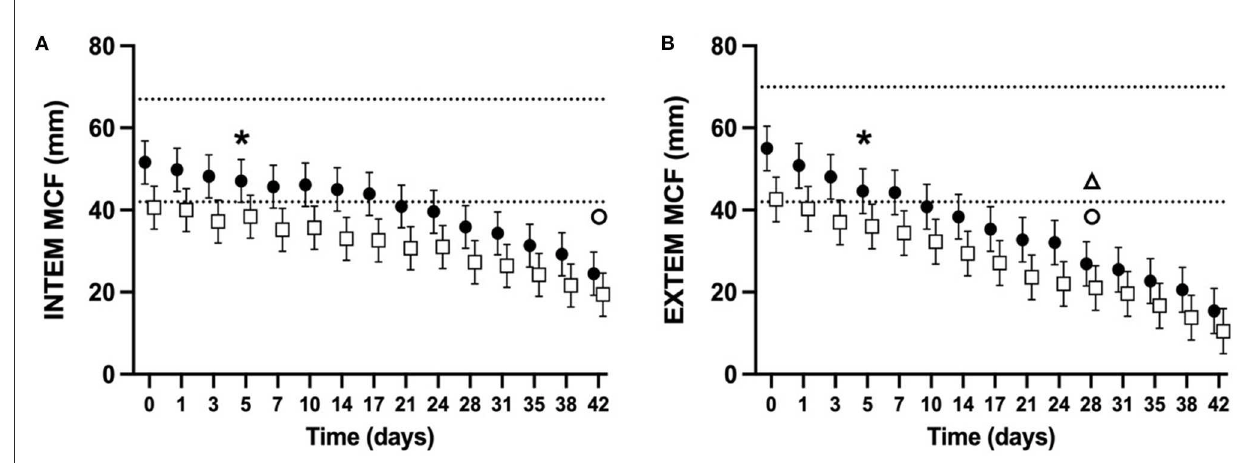
FIGURE4 Serial estimated marginal means and 95% confidence intervals for the INTEM (A) and EXTEM (B) maximum clot firmness (MCF) of whole blood (CSWB) from non-greyhound ( • ) and greyhound ( (cid:3) ) dogs cold-stored for 42 days. The open triangle ( 1 ) and open circle (o) denotes when the estimated marginal mean falls below 50% of baseline for non-greyhound and greyhound CSWB, respectively. The dotted lines represent the institutional reference interval for freshly collected non-greyhound dog citrated whole blood. The asterisk (*) indicates when the lower bound of the